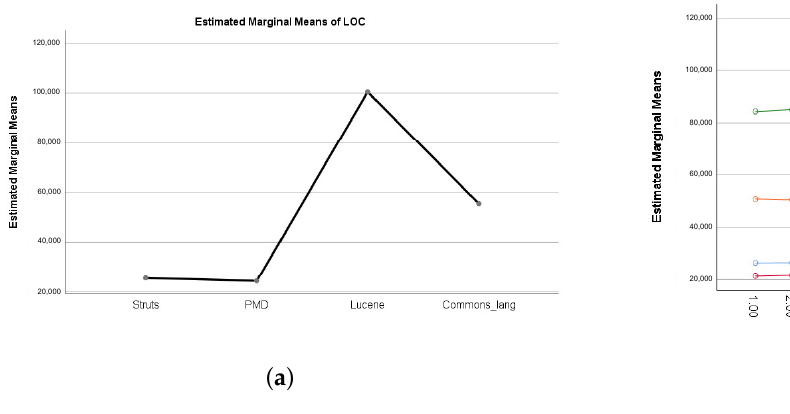
Figure 2. Estimated Marginal Means of